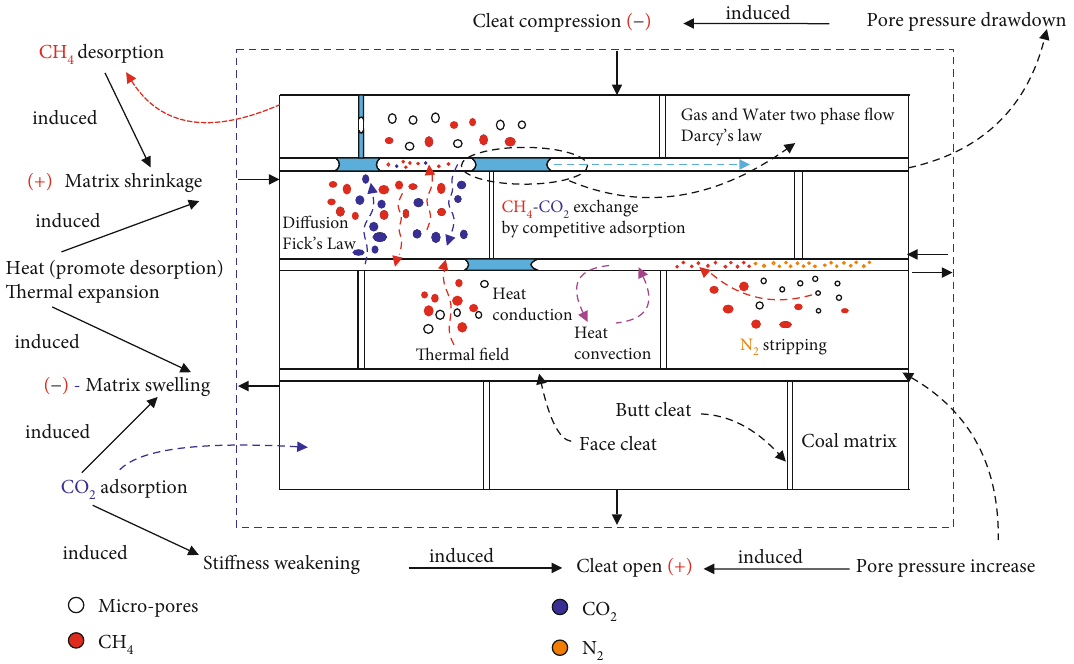
Figure 1: Mass transport processes for binary gas (CO